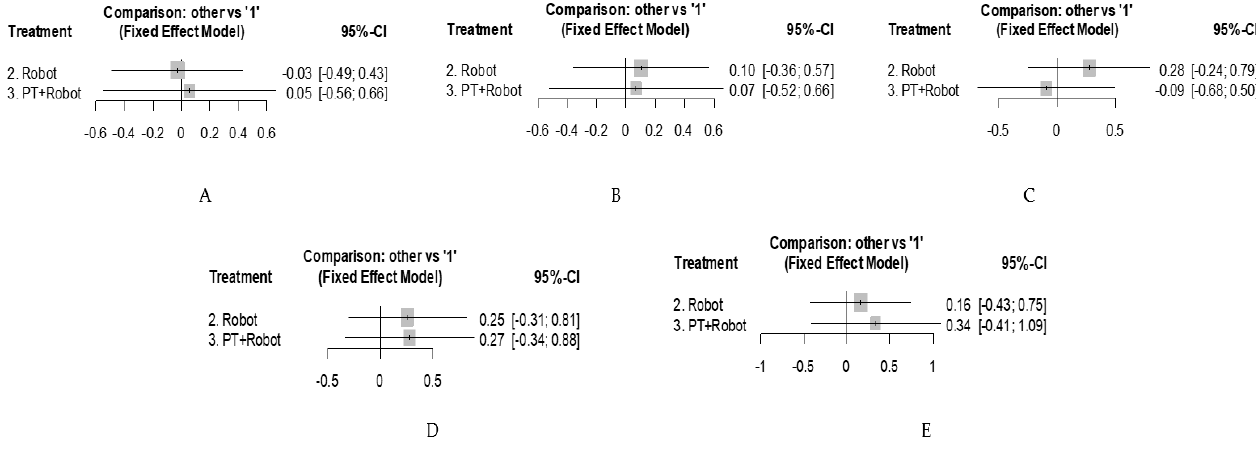
Figure 3. Forest plot of the standardized mean change index calculated for the comparisons of robot-assisted training vs. physiotherapy and physiotherapy + robot-assisted training vs. physiotherapy: ( A ) gross motor function measure dimension D; ( B ) gross motor function measure dimension E; ( C ) speed; ( D ) endurance; and ( E ) step length. ‘1’: physiotherapy. Table 4. Results for components.